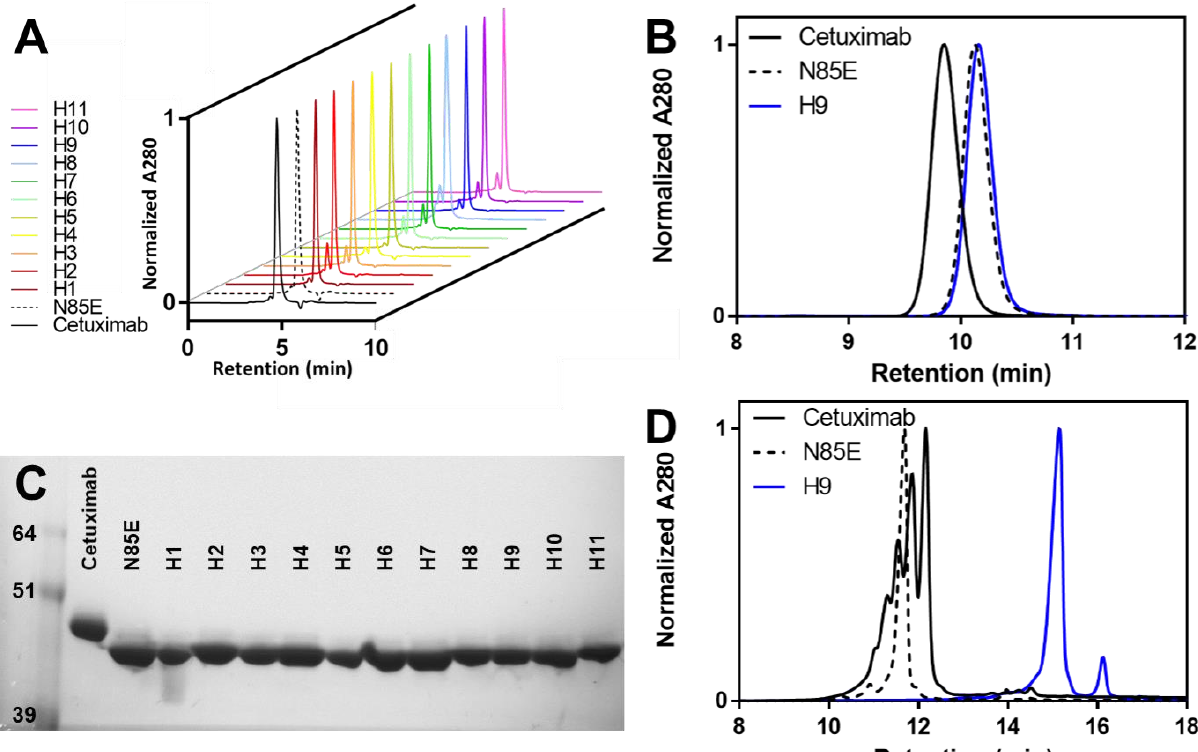
Figure 2 . Purification data for cetuximab-derived scFv-monoFc proteins and mAbs. ( A ) Analytical size-exclusion chromatograms for scFv-monoFc proteins immediately after first-step protein A purification demonstrate variable levels of aggregation. ( B ) Analytical size-exclusion chromatography for mAb proteins immediately after first-step protein A purification demonstrates low aggregation and smaller size upon humanization. ( C ) Non-reducing SDS-PAGE of purified scFv-monoFc proteins demonstrates a higher mobility of humanized versions lacking a glycosylation site. ( D ) Cation exchange chromatography of purified mAbs demonstrates an increase in PI and a reduction in charge variants upon humanization. Data are representative of two independent expressions and purifications, except the ion exchange data, which were only collected once. N85E is aglycosylated cetuximab, and H1 through H11 are humanized variants.